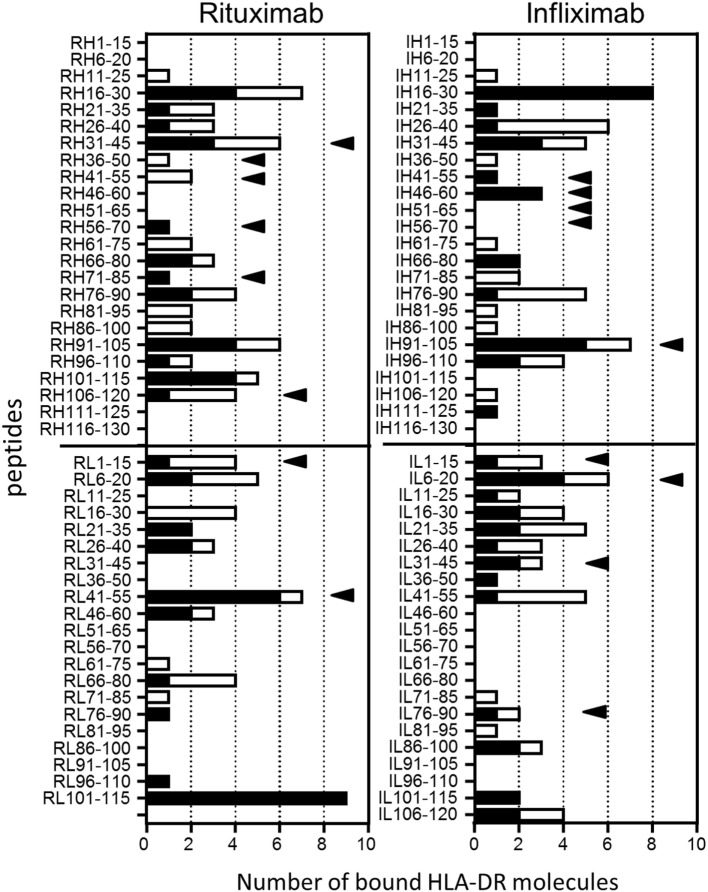
Binding of rituximab (Rtx) and infliximab (Ifx) overlapping peptides to common human leukocyte antigen (HLA)-DR molecules. Overlapping 15-mer peptides covering the whole sequence of the variable parts of Rtx and Ifx were submitted to competitive ELISA specific for the following HLA-DR molecules: DRB1*01:01, *04:01, *11:01, *07:01, *01:01, *03:01, *09:01, *1301, *1501, DRB3*01:01, DRB4*01:01, and DRB5*01:01. Data are reported as number of bound HLA-DR molecules for each peptide. Relative affinity below 20 corresponds to strong binding (black), while moderate binding is in the range of 20–100 (blank). Black arrows: CD4 T cell epitopes.